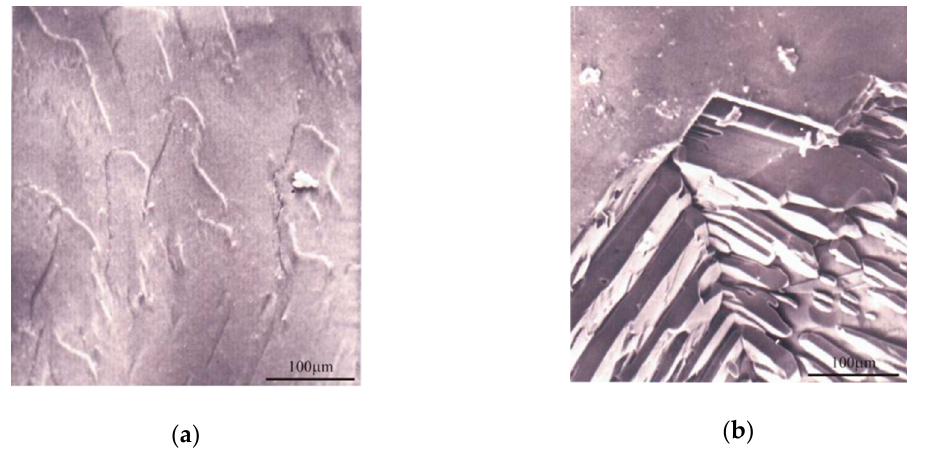
Figure 3. NdAl 3 (BO 3 ) 4 (NAB) epilayers grown on YAl 3 (BO 3 ) 4 (YAB) substrates: ( a ) σ = 0.02; ( b ) σ = 0.05 [34].